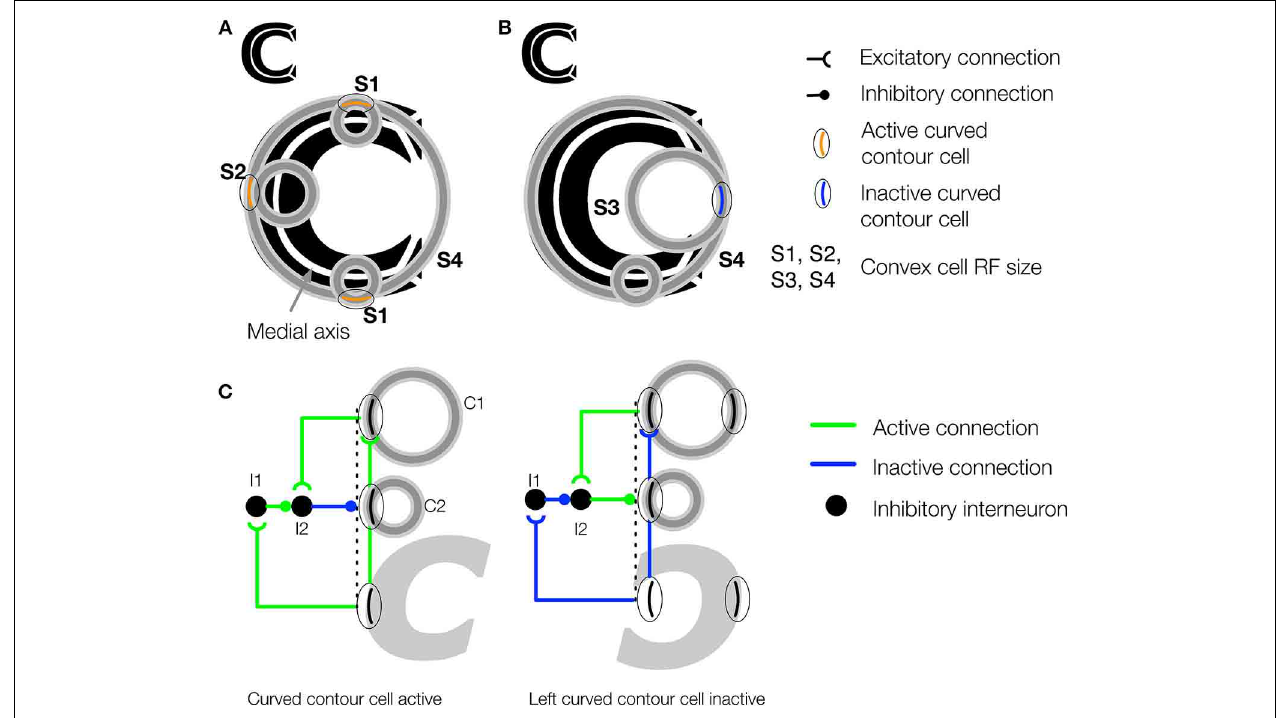
FIGURE 4 | The convex cell recurrent circuit suppresses responses outside of figures in concave regions. (A) The medial axis of the C-shape is superimposed on the figure in white. Units with small RF sizes (S1 and S2) detect points along the medial axis. (B) Without feedback, units (S3) may incorrectly detect a medial axis within the concave region of the C-shape display. Ambiguity about the correct location of the medial axis is resolved in the model through feedback from large RF units (S4), which respond to the closure of the figure’s boundary. (C) Proposed neural circuit for the model’s convex cell recurrent feedback mechanism. Curved contour cells project to a convex